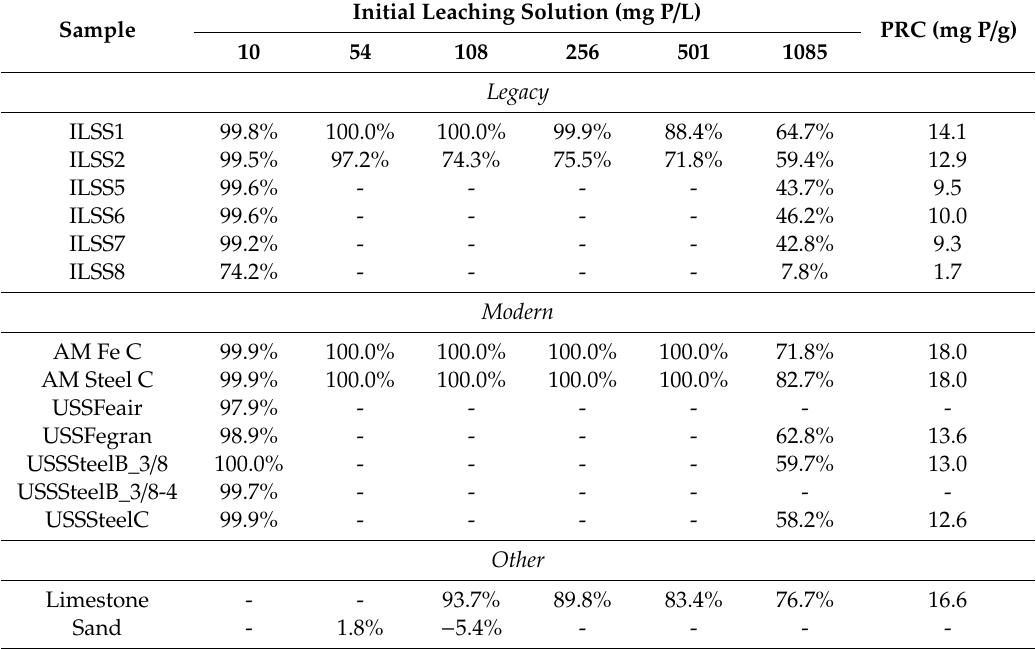
Table 4. Percent phosphate removed and phosphate removal capacity (PRC) for modern and legacy steelmaking slags from the Chicago-Gary area, Illinois and Indiana, based on static batch experiments with various initial P leaching solution concentrations. PRC was calculated based on the 1085 mg P / L test results (see text for